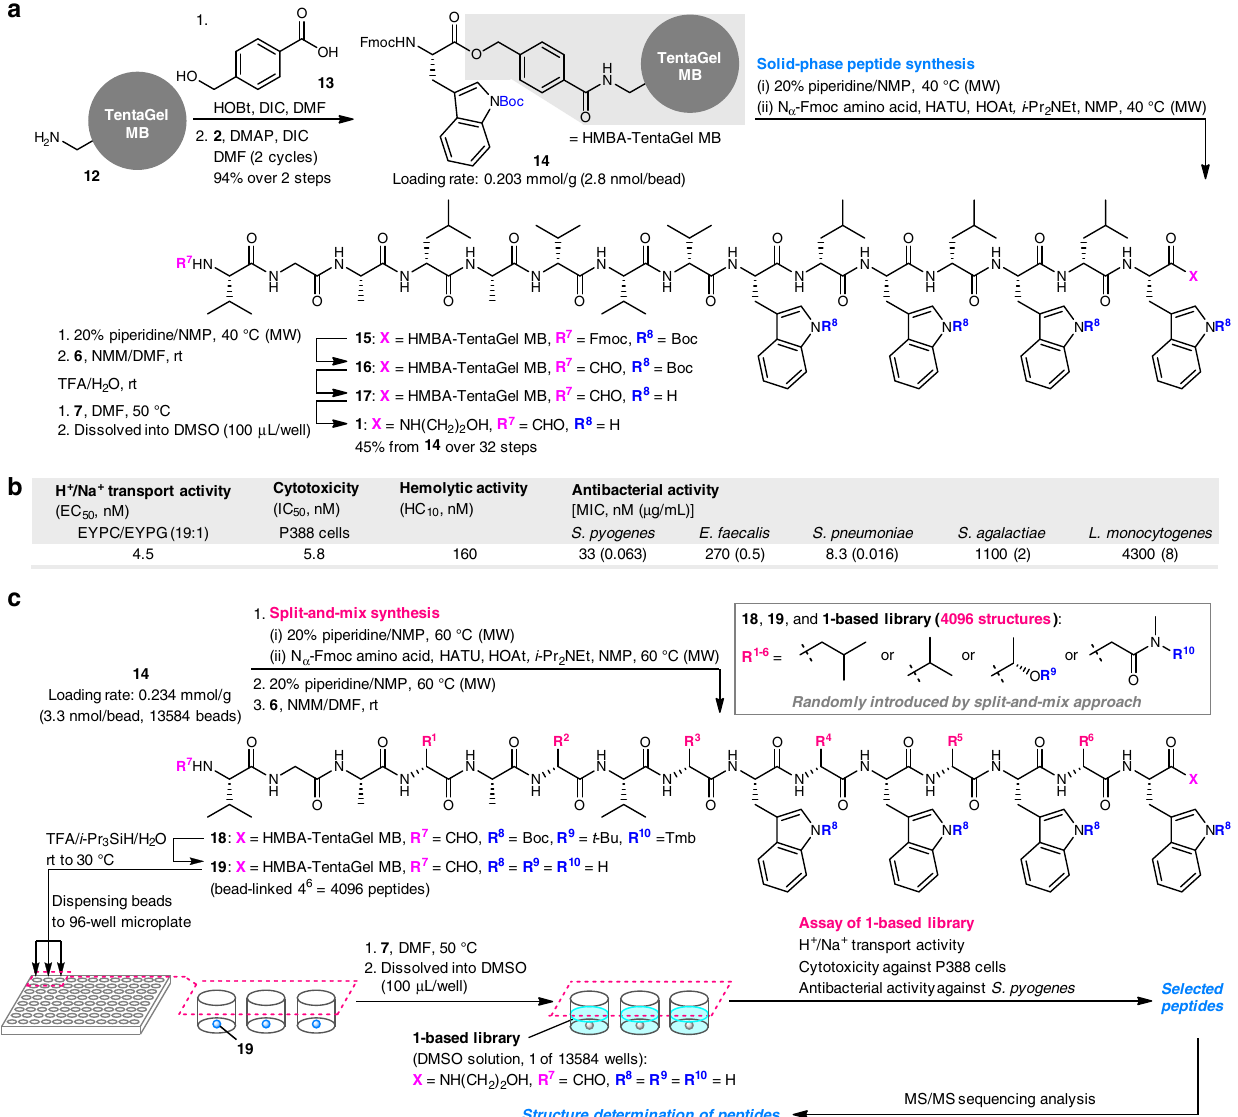
Fig. 2 Pilot study and construction of the 1-based OBOC library. a SPPS of 1 from TentaGel macrobeads 12 . b H + /Na + transport, cytotoxic, hemolytic, and antibacterial activities of 1 . c A high-throughput platform for constructing and screening 4096 gramicidin A analogues. DIC N , N ′ -diisopropylcarbodiimide, DMAP N , N -dimethyl-4-aminopyridine, HATU O -(7-aza-1 H -benzotriazol-1-yl)- N , N , N ′ , N ′ -tetramethyluronium hexa fl uorophosphate, HMBA hydroxymethylbenzoic acid, HOAt 1-hydroxy-7-azabenzotriazole, HOBt 1-hydroxybenzotriazole, HC 10 concentration causing 10% hemolysis, MIC minimum inhibitory concentration, MW microwave, NMM N -methylmorpholine, TentaGel MB TentaGel macrobeads, TFA tri fl uoroacetic acid, EC 50 median effective concentration, EYPC egg yolk phosphatidylcholine, EYPG egg yolk phosphatidylglycerol, IC 50 median inhibitory concentration. MICs ( μ g/mL) were determined by the microdilution method. S. pyogenes Streptococcus pyogenes SSI-9, E. faecalis Enterococcus faecalis JCM5803, S. pneumoniae Streptococcus pneumoniae NBRC 102642, S. agalactiae Streptococcus agalactiae JCM5671, L. monocytogenes Listeria monocytogenes method 59 . Hemolytic activity was evaluated by monitoring mixture of egg yolk phosphatidylcholine (EYPC) and egg yolk phosphatidylglycerol (EYPG) 57 . Pyranine, a pH-dependent fl uor- hemoglobin leakage from rabbit red blood cells as a consequence escent dye 58 , was encapsulated in the LUVs and a pH gradient of membrane damage. The concentration of 1 required to cause was applied across the membrane. H + /Na + transport induced by 10% hemoglobin leakage (HC 10 ) was 160 nM. Thus, the P388 a peptide was monitored by changes in the fl uorescence intensity cytotoxicity of 1 was 28-fold more sensitive than its hemolytic of pyranine. By measuring the fl uorescence changes (%) caused activity. by varied concentrations of 1 , we quanti fi ed the half-maximal Third, 1 was subjected to fi ve pathogenic Gram-positive bacteria. response (EC 50 ) value as 4.5 nM. The minimum inhibitory concentrations (MIC) of 1 were 33 nM Second, we examined the cytotoxicity toward mammalian ( Streptococcus pyogenes ), 270 nM ( Enterococcus faecalis ), 8.3 nM cancer cells and hemolytic activity of 1 . We determined the ( Streptococcus pneumoniae ), 1100 nM ( Streptococcus agalactiae ), and median inhibitory concentration (IC 50 ) against P388 mouse 4300 nM ( Listeria monocytogenes ). The antibacterial activities of 1 leukemia cells to be 5.8 nM using the 4-[3-(4-iodophenyl)-2-(4- varied signi fi cantly among strains and S. pyogenes and S. pneumoniae nitrophenyl)-2 H -5-tetrazolio]-1,3-benzene disulfonate colorimetric were found to be the most susceptible strains.